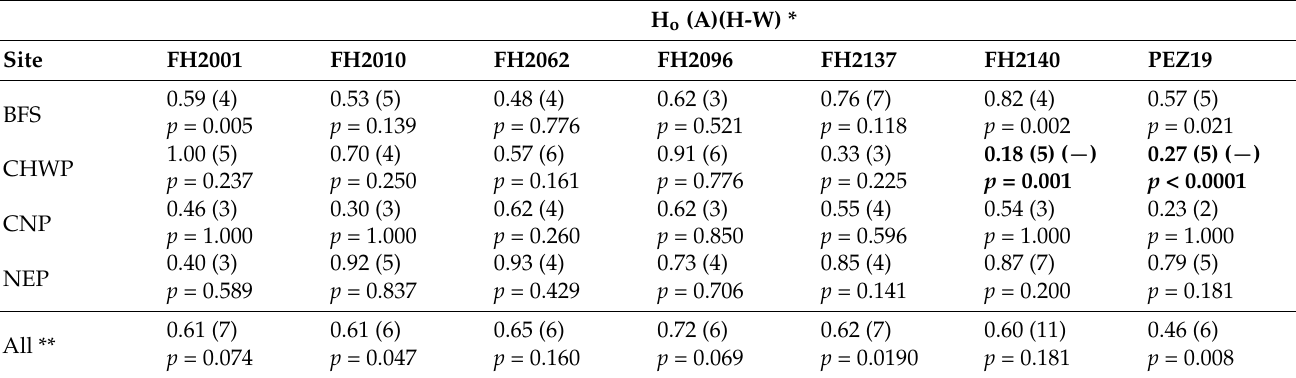
Table 1. Observed heterozygosity, allelic richness, and Hardy–Weinberg deviation by locus.